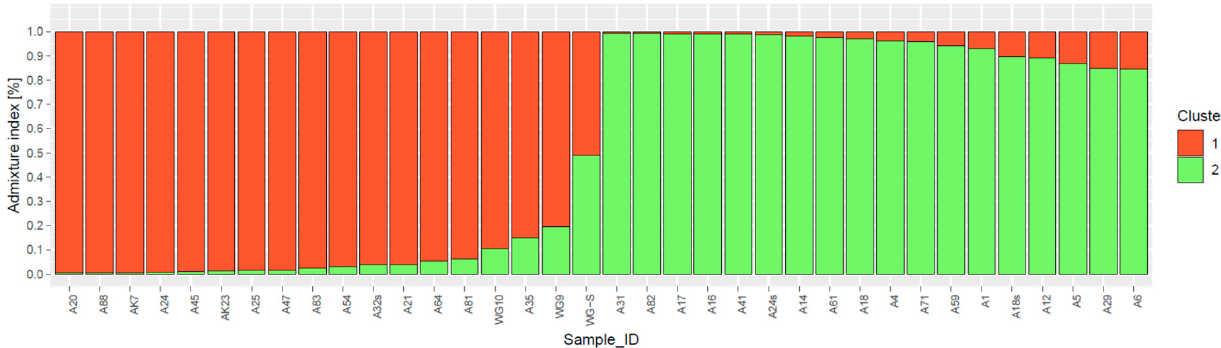
Figure 4. Bayesian ‐ model ‐ based estimation of population structure ( K = 2) for the 36 Bipolaris soro ‐ Figure 4. Bayesian-model-based estimation of population structure ( K = 2) for the 36 Bipolaris kiniana isolates in 2 pre ‐ determined populations. Each group is separated by a black vertical line. sorokiniana isolates in 2 pre-determined populations. Each group is separated by a black vertical line. Numbers in the y ‐ axis show admixture index (%). Numbers in the y -axis show admixture index